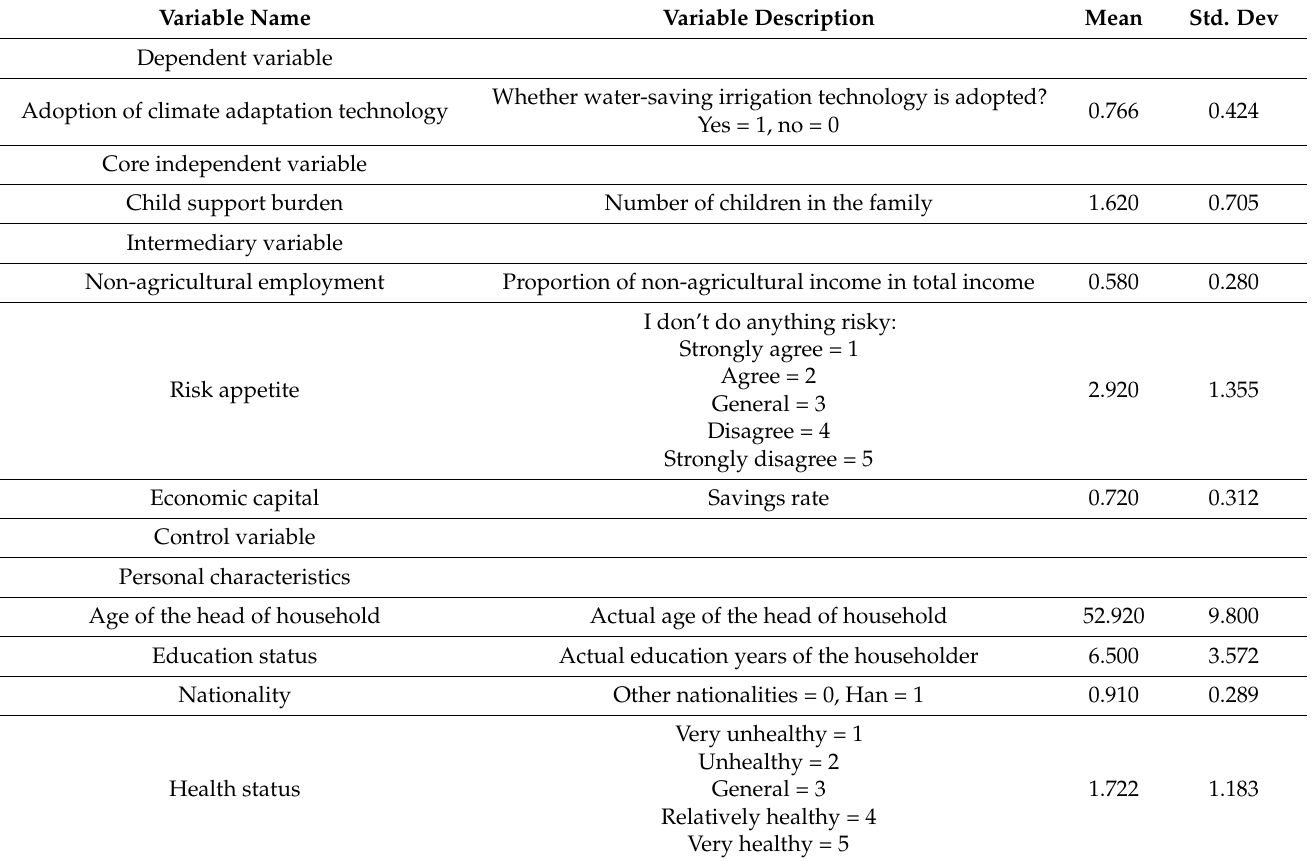
Table 2. Variable definition and descriptive